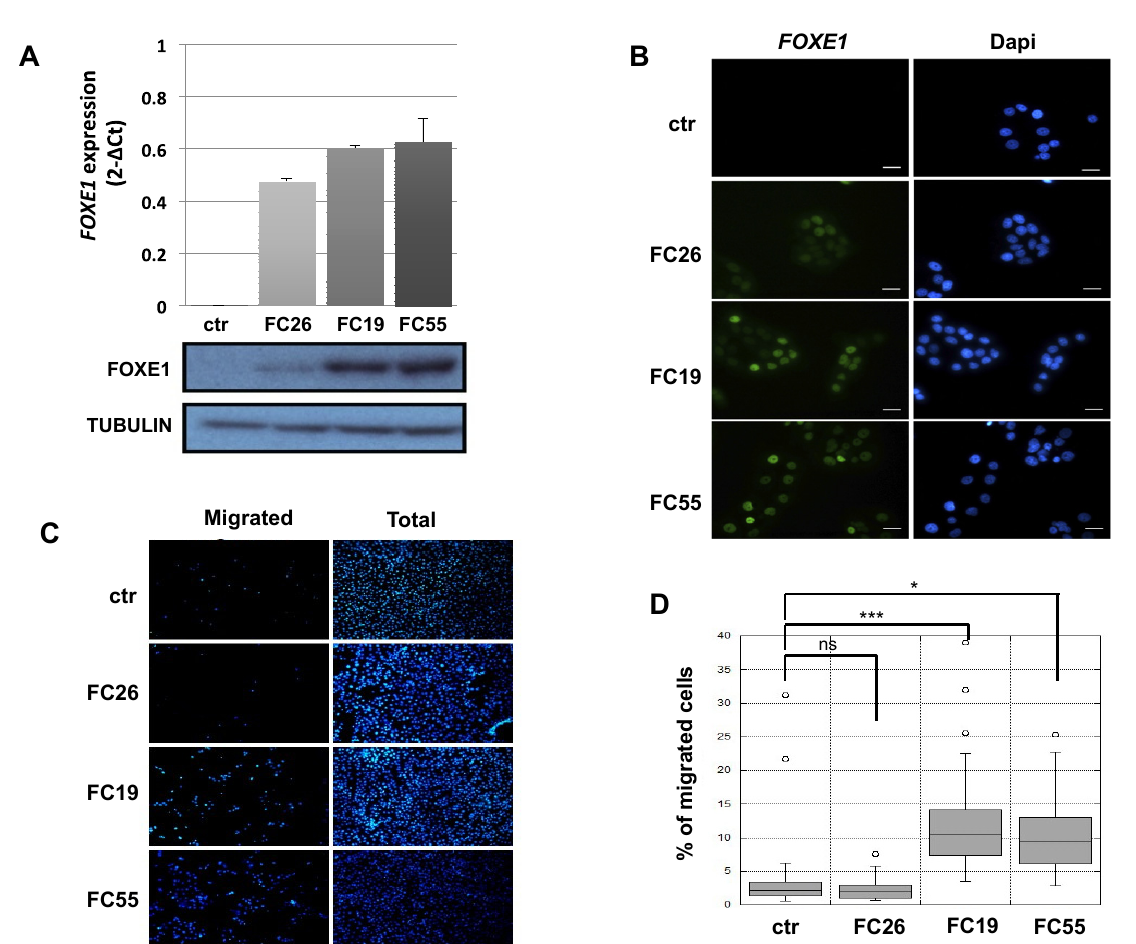
Figure 1. FOXE1 elicits thyroid cell migration of FOXE1-overexpressing clones. ( A ) FOXE1 expression in ctr cells and different FOXE1 clones (FC) analysed by qRT PCR (upper panel) and Western blot (bottom panel). Tubulin was used to normalise. ( B ) Immunofluorescence images of the same clones as in A, probed with anti-FOXE1 antibody, showing nuclear FOXE1 localisation. Nuclei are stained with Dapi. 40 × magnifications are shown. The scale bar represents 20 um. ( C ) Transwell assay performed on control cells (ctr) and FOXE1-expressing clones FC26, FC19, FC55. Representative images of the transwell used before (total) and after (migrated) swab cleaning of the inner part of the upper chamber. Cells were stained with Dapi in order to visualise the nuclei. ( D ) The percentage of migrated on total cells was calculated. One-way ANOVA test was performed on data, and p -values are reported for each clone relative to ctr. * p < 0.05, *** p < 0.001, ns: not significant.